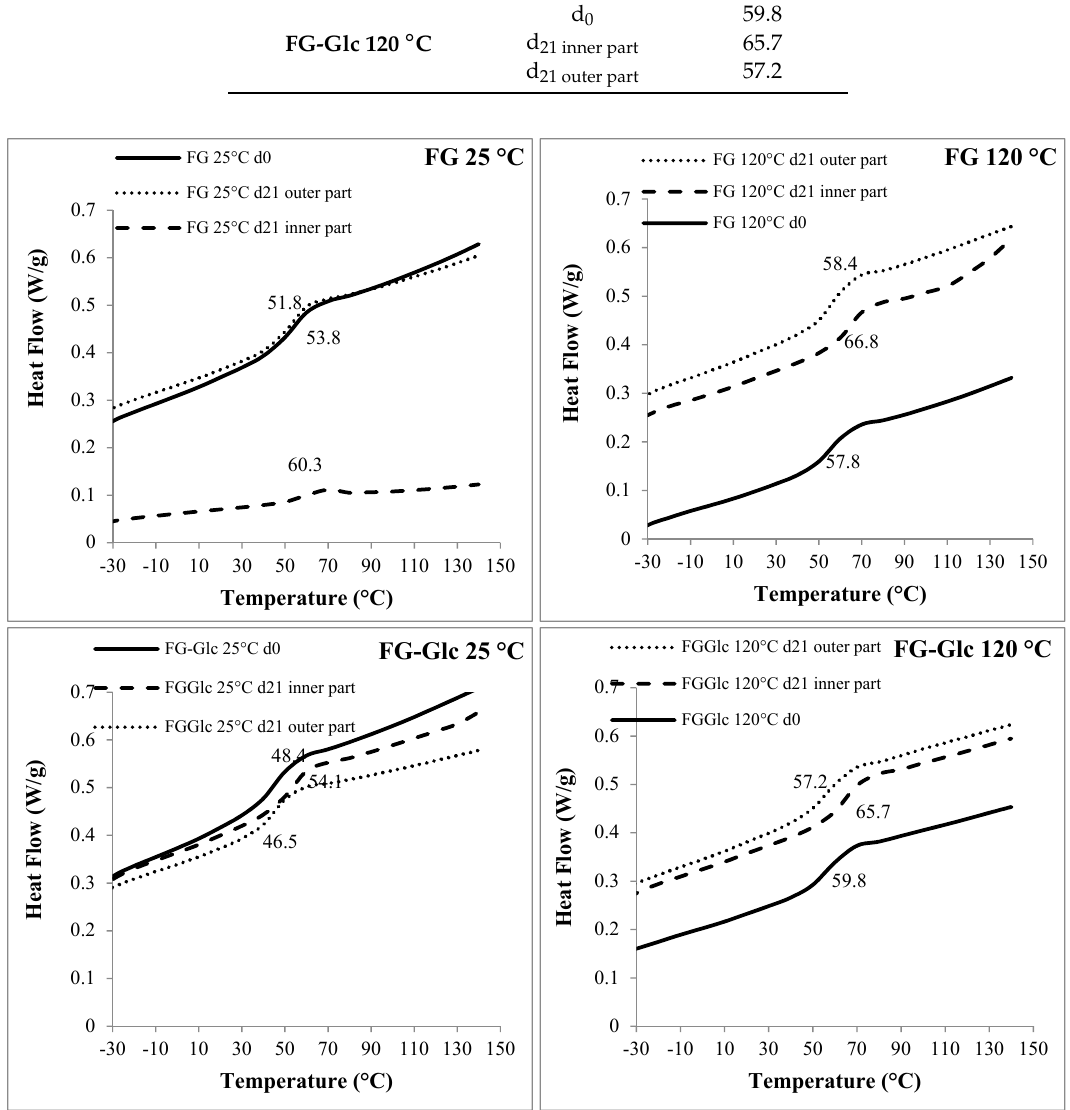
Figure 7. Differential scanning calorimetry (DSC) curves of FG and FG-Glc pouches at d 0 and after application (d 21 ).